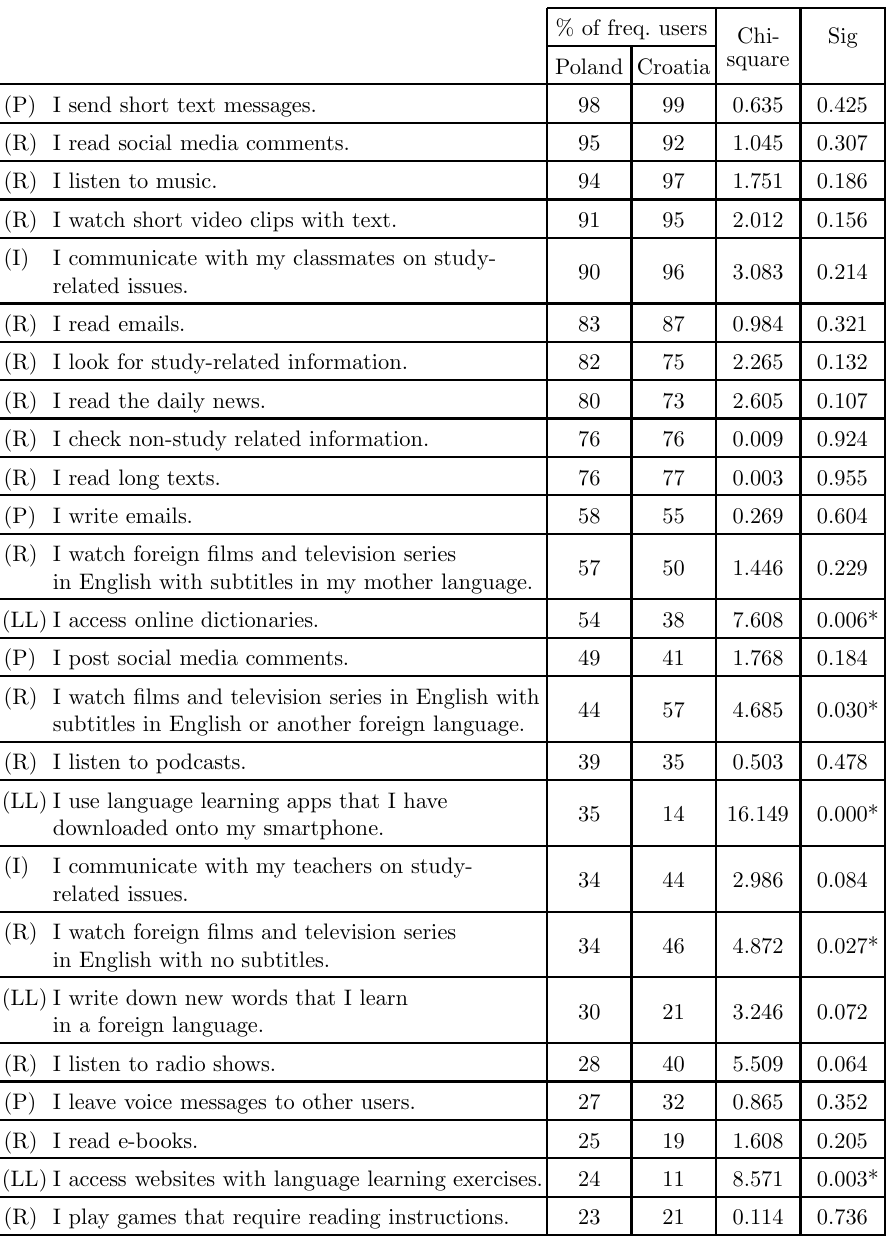
Table 3 Shares of frequent users of online smartphone activities among the Polish and Croatian participants % of freq. users